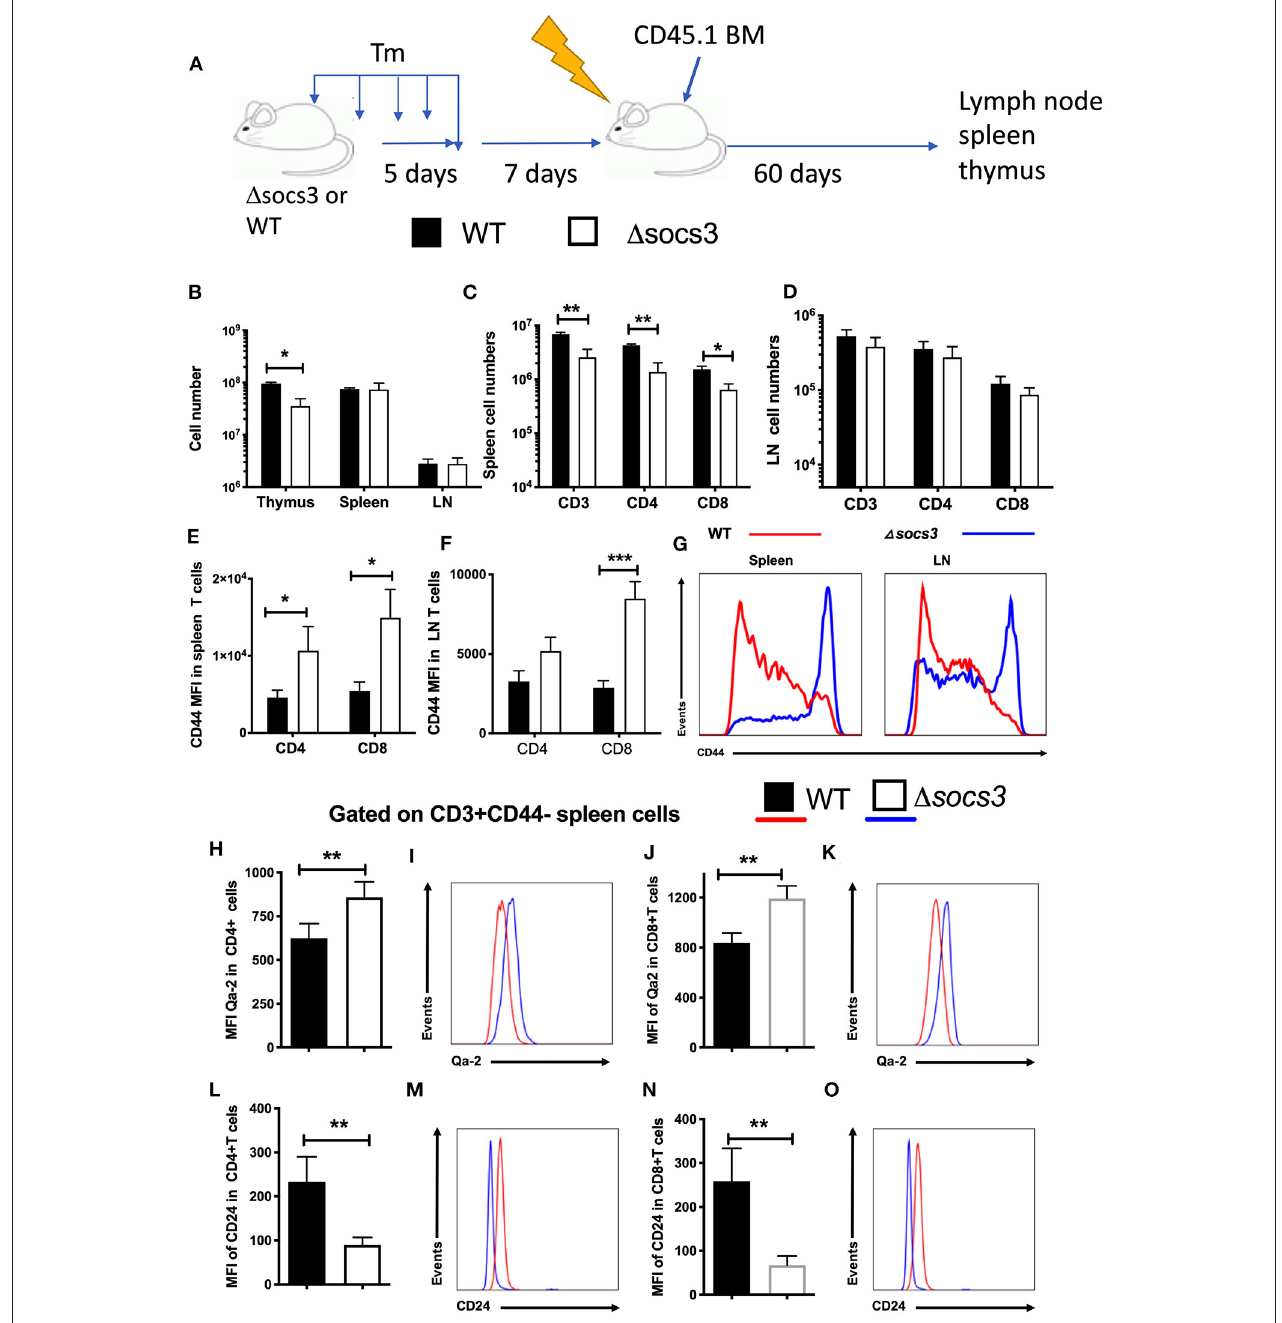
FIGURE 5 | Non-hematopoietic SOCS3 expression regulates the frequency recent thymic emigrants and of naïve peripheral T cells. (A) WT or 1 socs3 mice treated with Tm and 7 days after the last dose of Tm were irradiated and transplanted with CD45.1 + WT bone marrow cells. Mice were sacrificed 60 days after BM transplantation. (B) The mean number of thymus, spleen and lymph node cells ± SEM of transplanted mice are depicted ( n = 5 per group). The mean number ± SEM of CD45.1 + and CD3 gated CD4, CD8, and γδ T cells in (C) spleens and (D) lymph nodes of radiation chimeric mice treated as described above is shown ( n = 5 per group). The mean MFI of CD44 in CD45.1 gated CD4 or CD8T cells in spleens (E) and lymph nodes (F) is shown. (G) A representative histogram of CD44 in CD8T cells in lymph node or spleen cells from 1 socs3 and WT mice. The mean MFI and representative histograms of Qa-2 (H–K) and CD24 (L–O) expression in naïve CD4 (H,I,L,M) and CD8 (J,K,N,O) splenic T cells of WT and 1 socs3 mice 7 days after Tm treatment are depicted. Differences between groups are significant at * p ≤ 0.05, ** p ≤ 0.01, *** p ≤ 0.001, unpaired Student’s t -test.